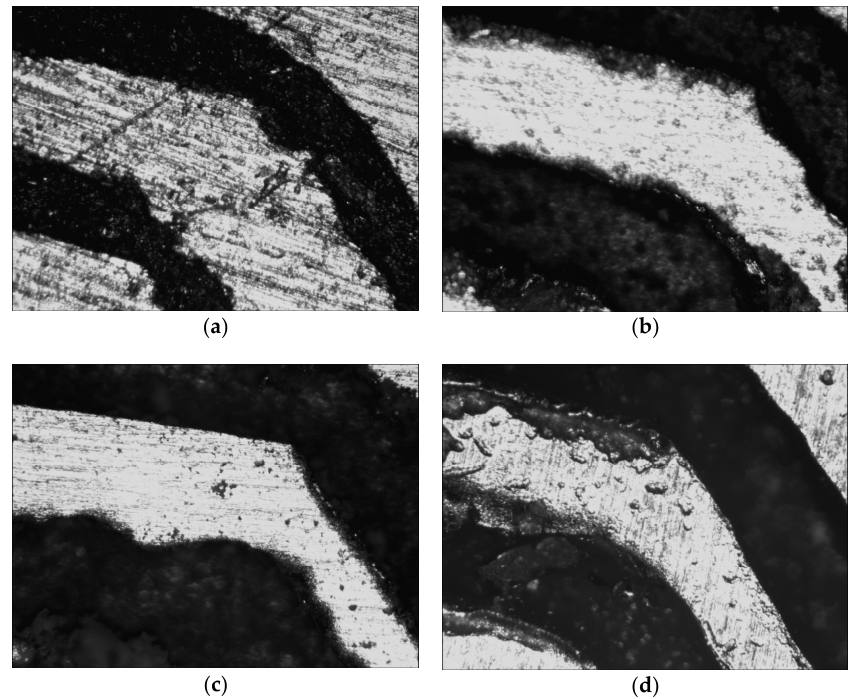
Figure 10. Top row from left to right: ( a ) Feed rate of 50 mm/min, plunge depth of 0.1 mm; ( b ) feed rate of 100 mm/min, plunge depth of 0.1 mm; ( c ) feed rate of 150 mm/min, plunge depth of 0.1 mm; and ( d ) feed rate of 50 mm/min, plunge depth of 0.2 mm.